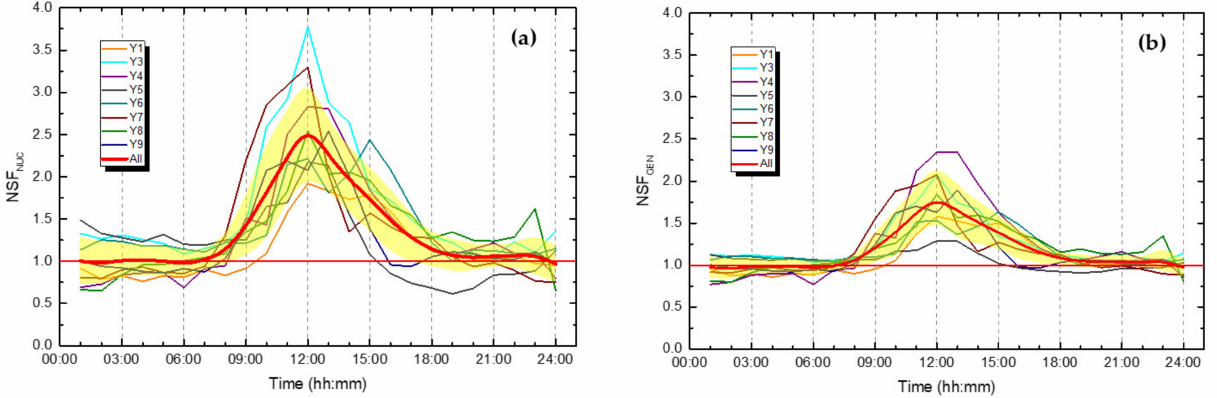
Figure 7. Diurnal variations in nucleation strength factor on a nucleation day (NSF NUC ) ( a ) and on a general day (NSF GEN ) ( b ) in the city center during the 8-year-long time interval. The factors were calculated in each year for the month in which the counts of the nucleation days were maximal. The red curve indicates the overall mean NSF value, the yellow band represents its ± 1 standard deviation and the horizontal solid black line at unity serve as a